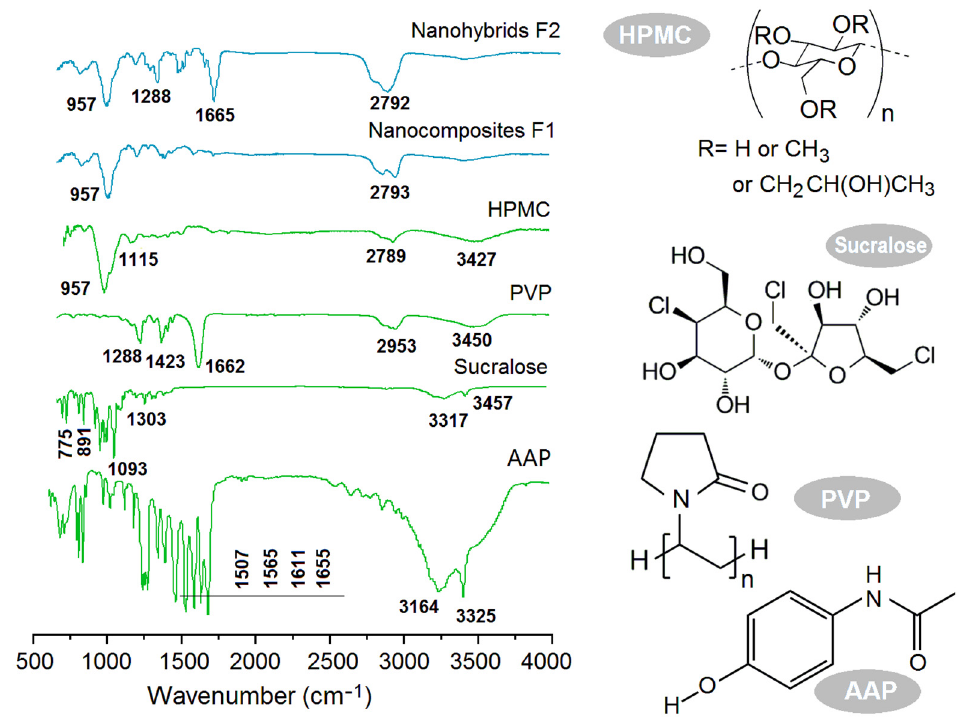
Figure 6. ATR-FTIR spectra of the starting raw materials (HPMC, ATP, PVP and sucralose), their different electrospun products and their molecular formulae.